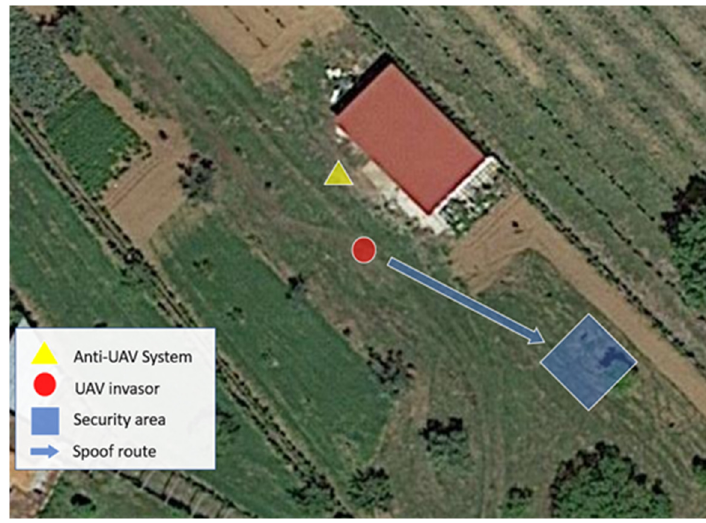
Figure 15. Real test scenario using spoofing signals.